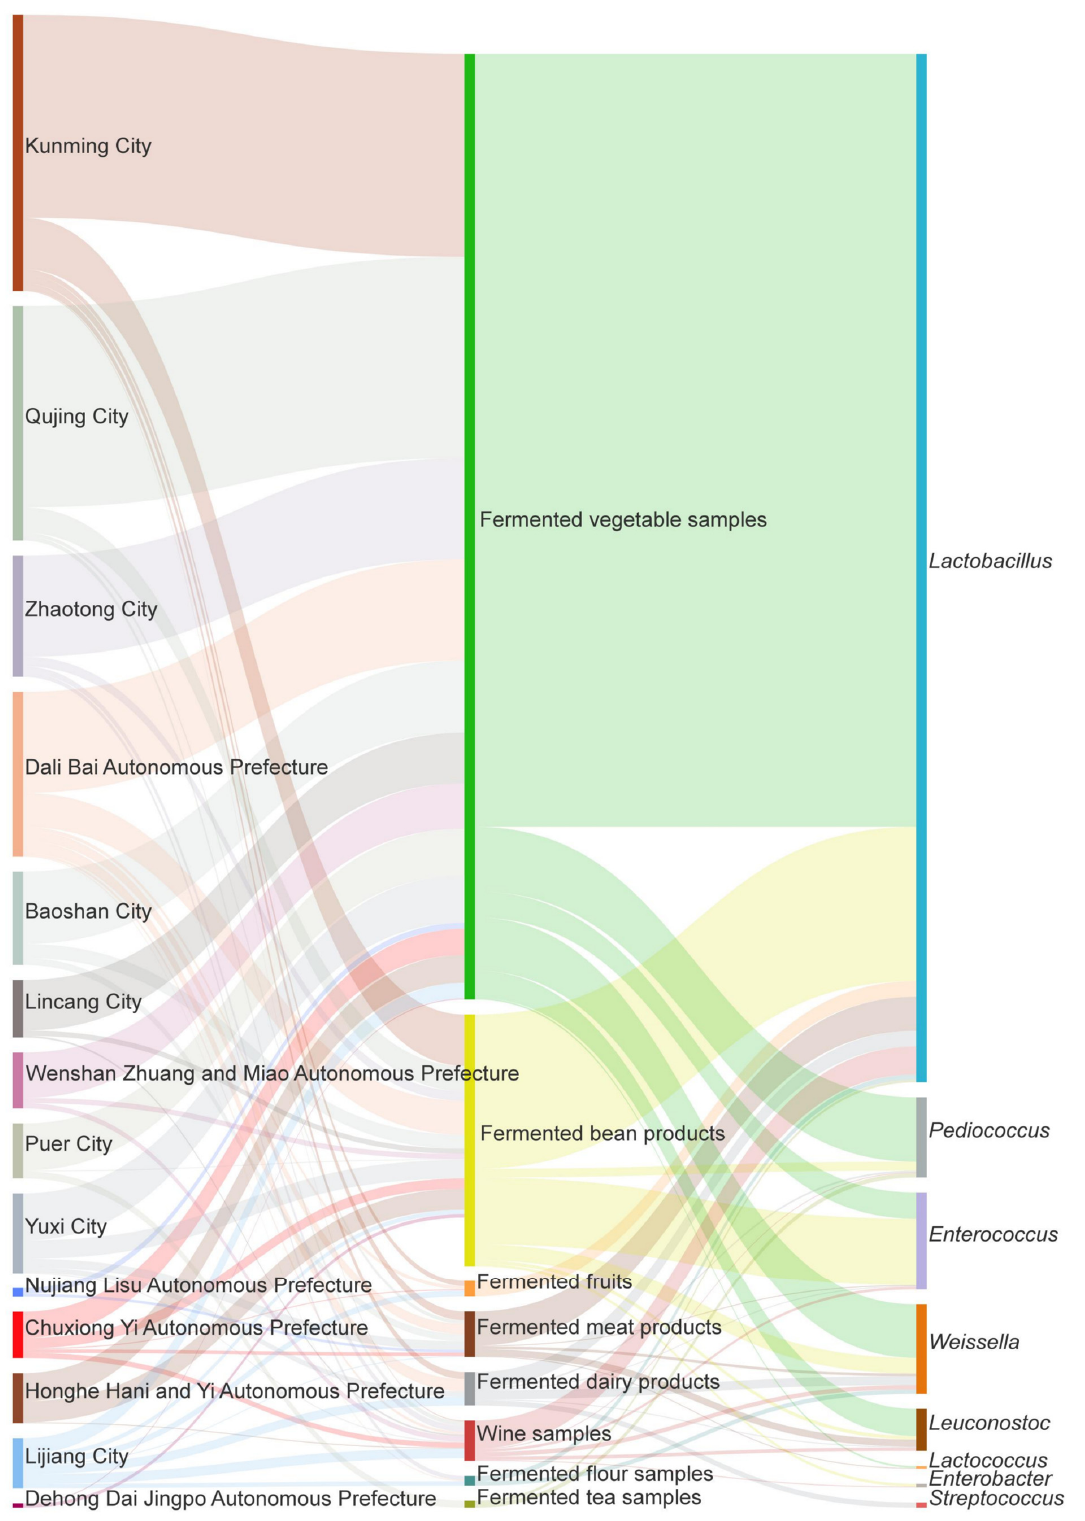
Figure 2. A Sankey diagram showing the relationships among regions, fermented foods and species.